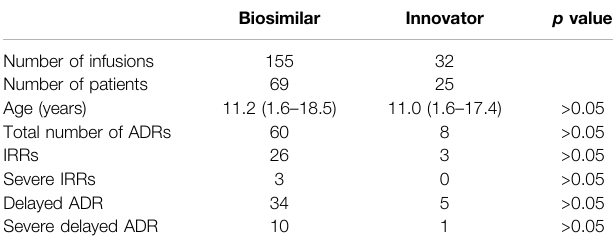
TABLE 4 | Number of infusions with ADR in the study population.